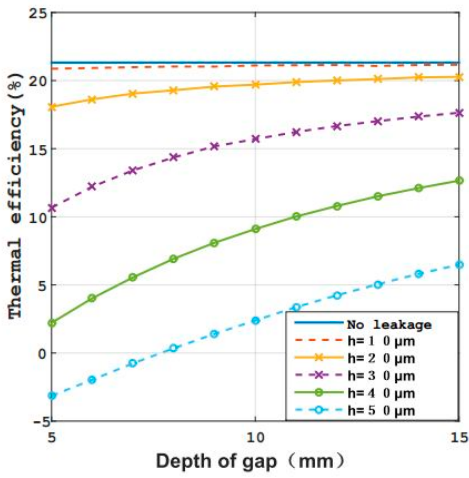
Figure 21. Engine efficiency vs. gap length under different gap heights.